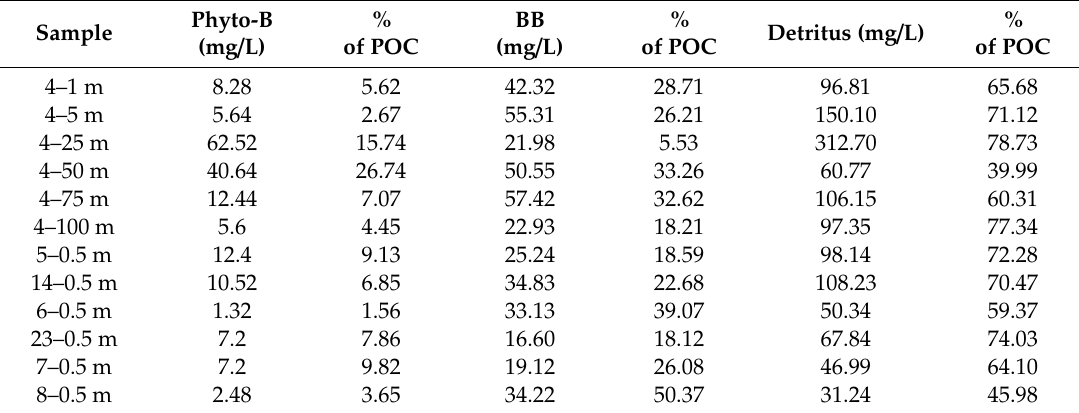
Table 3. Relative contribution of phytoplanktonic biomass (Phyto-B), prokaryotic biomass (PB), and detritus to total Particulate Organic Carbon (POC)